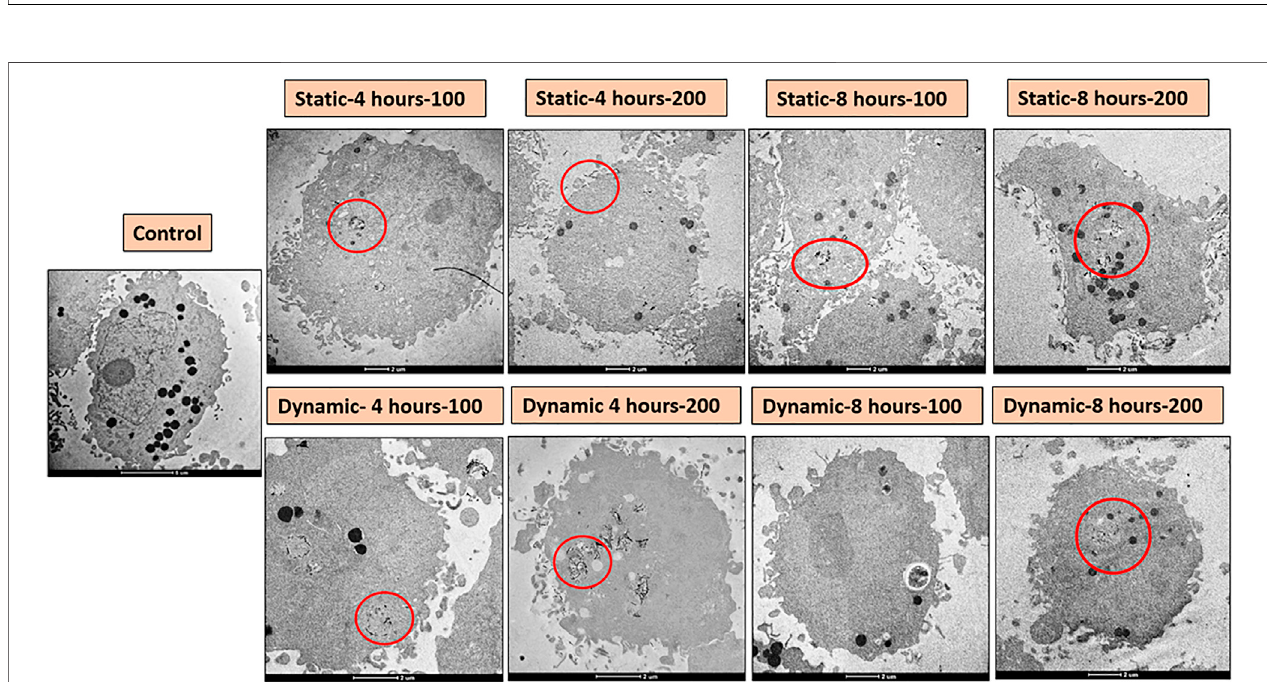
FIGURE 4 | Confocal images for MXene-treated cells under static and dynamic conditions. The golden arrow represents where MXene is located. The fi gure represents few MXene particles inside the cells (sliced 3D image) without any signi fi cant difference between static and dynamic conditions.